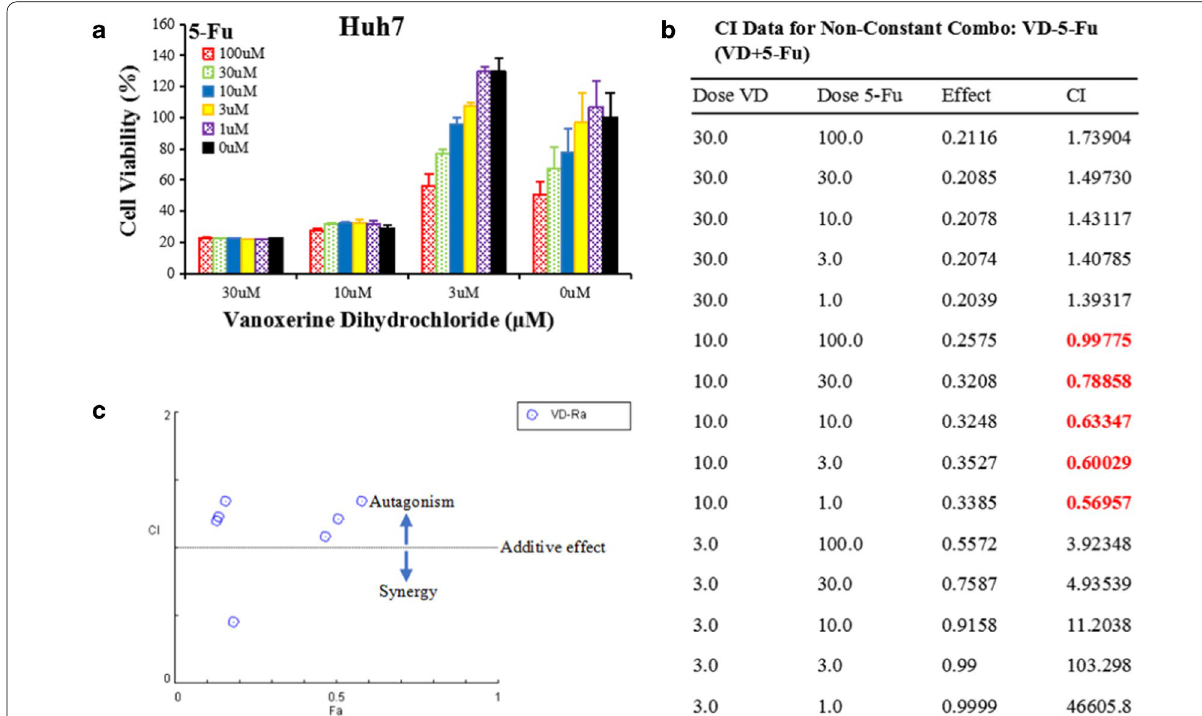
Fig. 7 Combination of vanoxerinedihydrochloride and 5‑FU produced synergistic cytotoxic effects in Huh7 cells. Huh7 cells were seeded in 96‑well plates, and treated with indicated concentrations of vanoxerine dihydrochloride and 5‑Fu. a Cell viability was detected by CCK8 after 72 h treatment. b The combined effect was analyzed by CompuSyn software analysis of the Combination Index (CI) of the combined action. c A dot plot of the combined action of vanoxerine dihydrochloride and